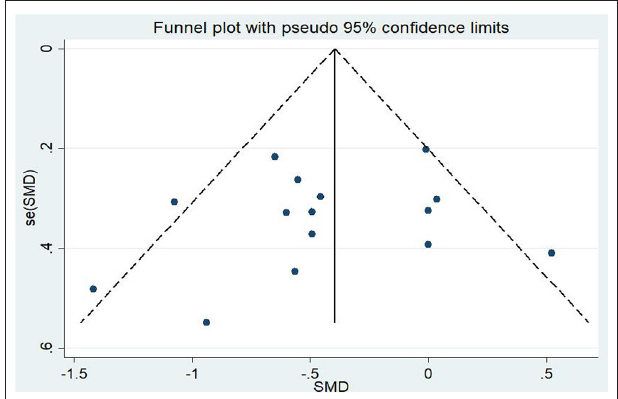
FIGURE 2 | Funnel plot of publication bias for